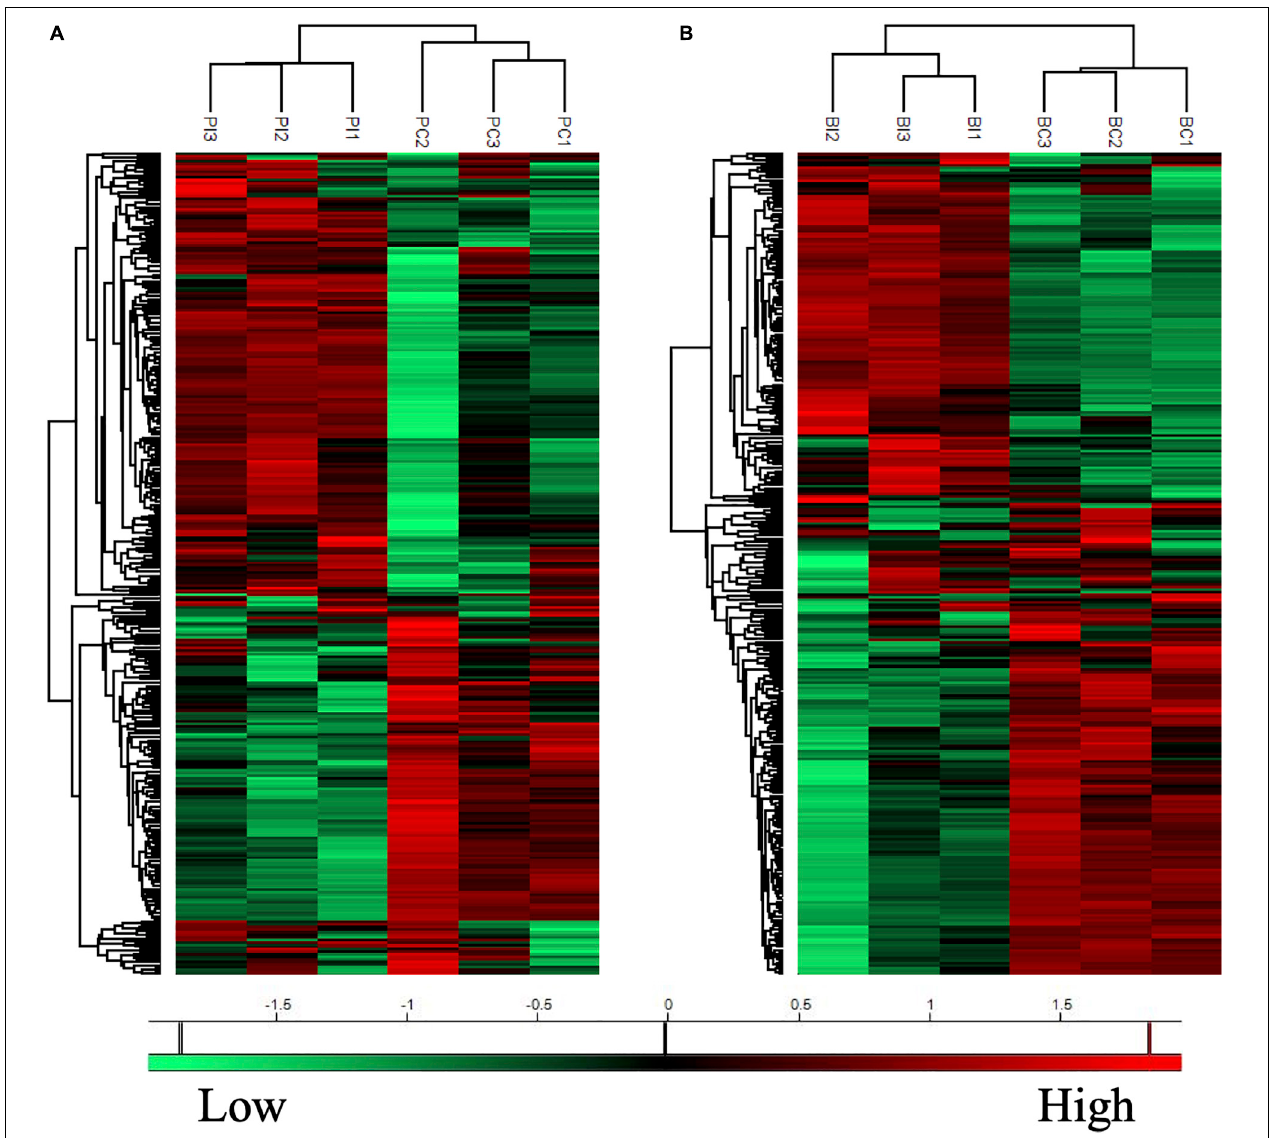
FIGURE 5 | Heatmaps of protein expression profiles of the planktonic cells (A) and biofilms (B) of C. albicans with or without CAS treatment. Treated (PI and BI) and untreated (PC and BC) samples are grouped separately in both planktonic cells and biofilms of C. albicans . Proteins with similar expression patterns are clustered in the left column trees. Scale bar depicts relative